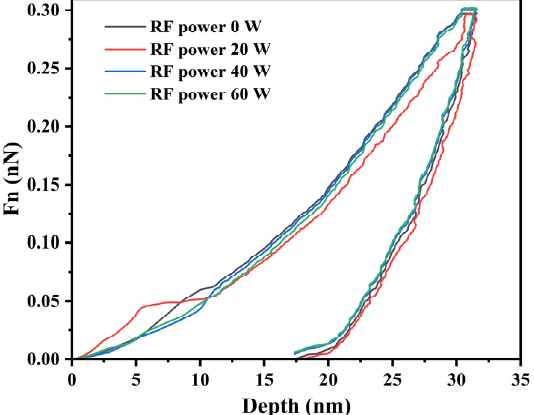
Figure 8. Load-displacement nanoindentation curves of the films deposited under different RF bias powers.